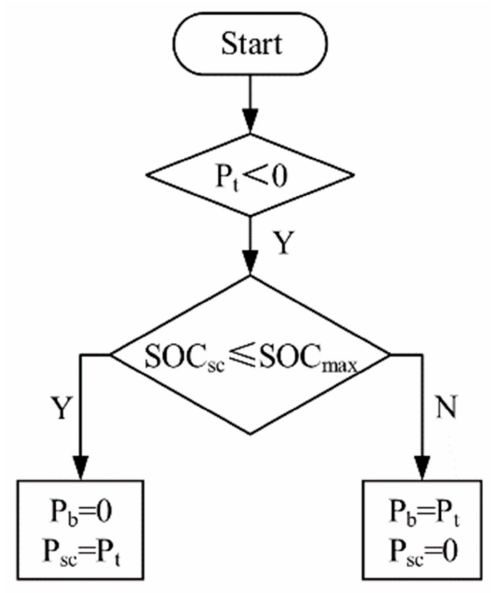
Figure 4. Flow chart of energy recovery under braking